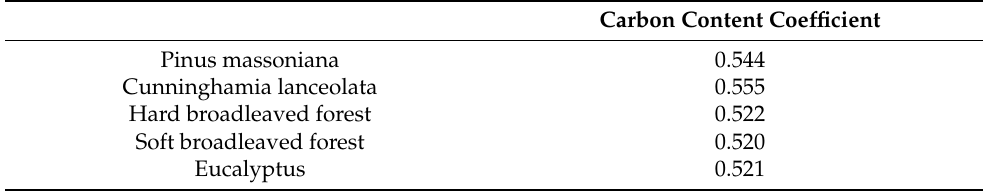
Table 1. Carbon content coefficient of different tree species (excerpt)